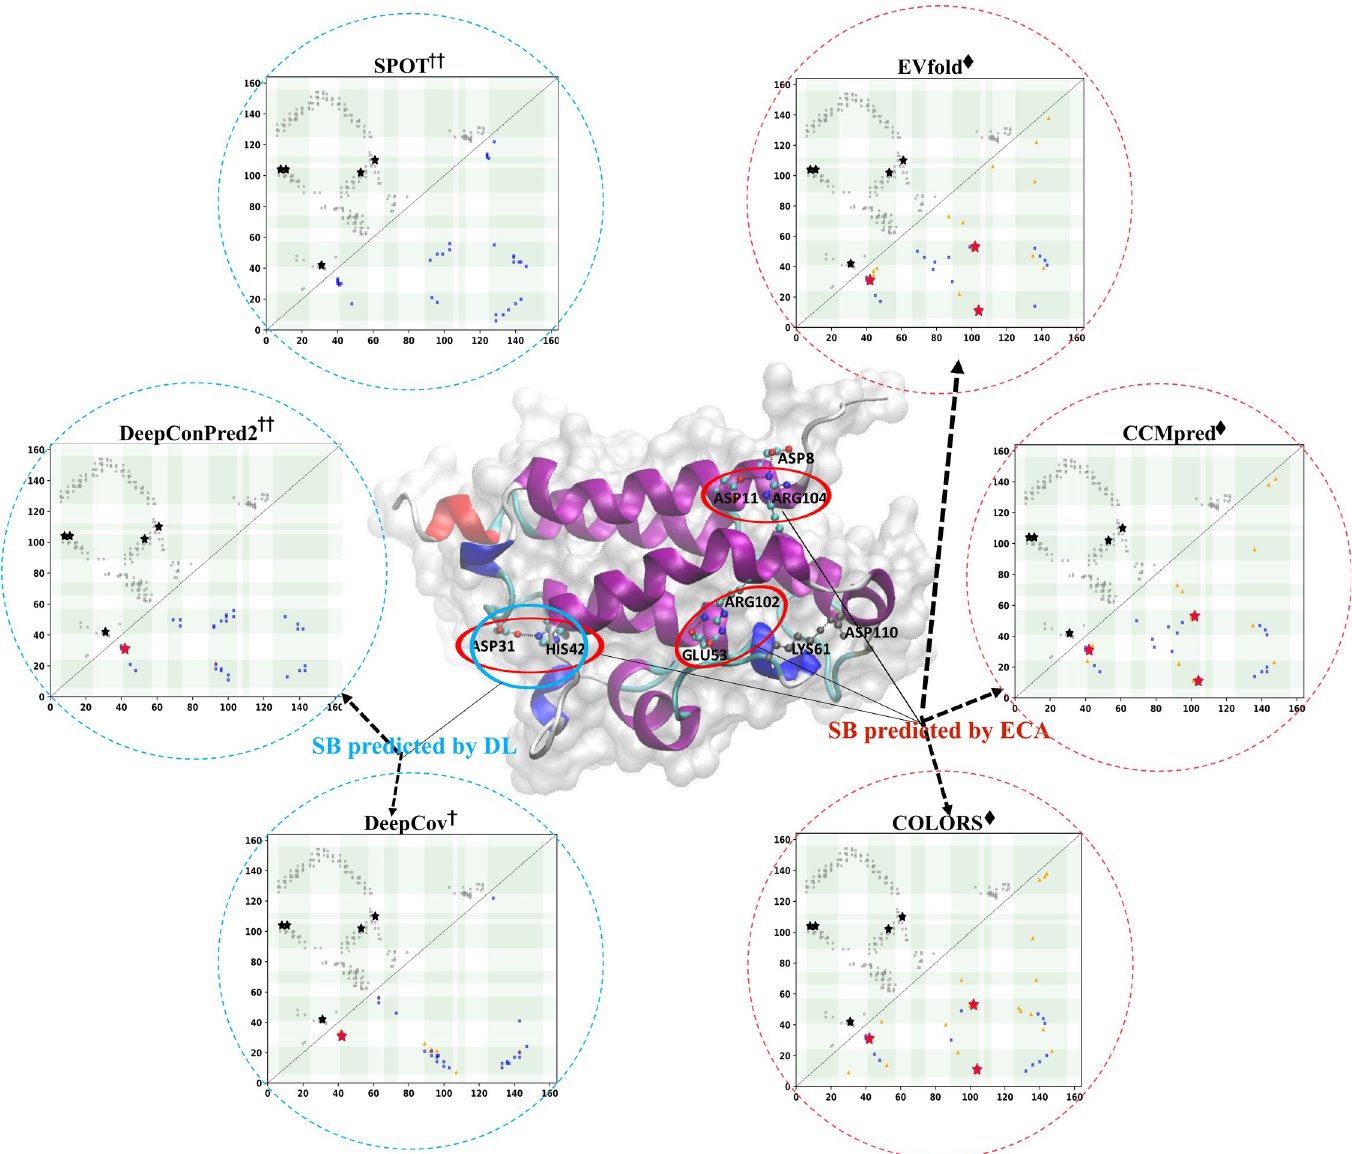
Fig 7. The predicted contact maps with salt bridges for 5WK0A (top L/5 predictions with a separation of no less than 6 residues). The cartoon at the center illustrates the salt bridges in the 3D structure. The gray square/blue square/orange triangle and black/crimson star stand for the native /true positive/ false positive contact and native/predicted salt bridge, respectively. ECA methods can detect more contacts related to salt bridges than ML and DL